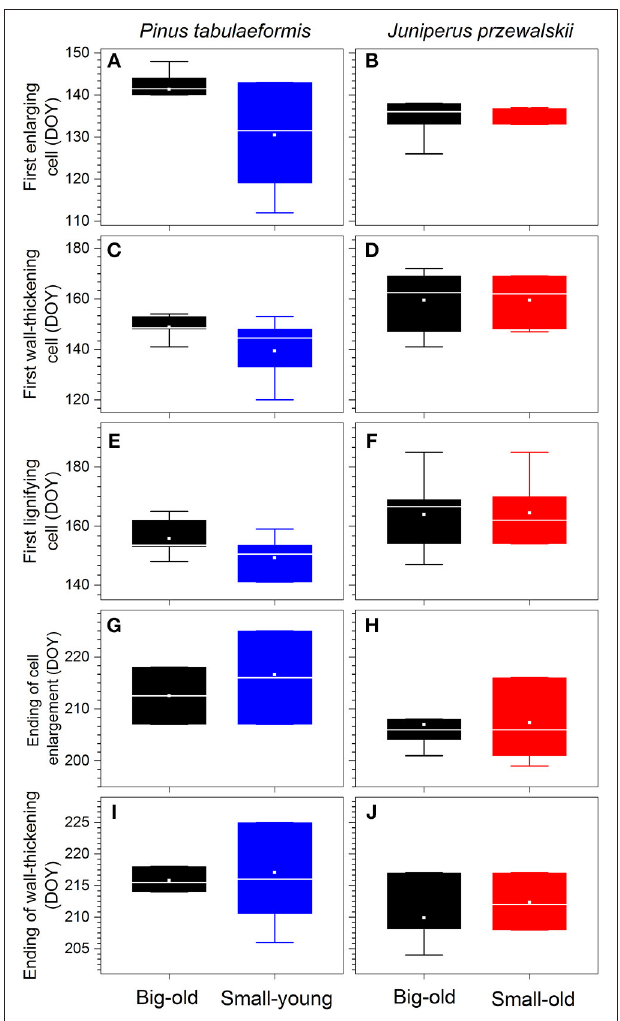
FIGURE 4 | Timings of xylem differentiation of each species. Boxes represent upper and lower quartiles; whiskers achieve the 10th and 90th percentiles; the median is drawn as a horizontal white line; and the average value is shown as a white square.